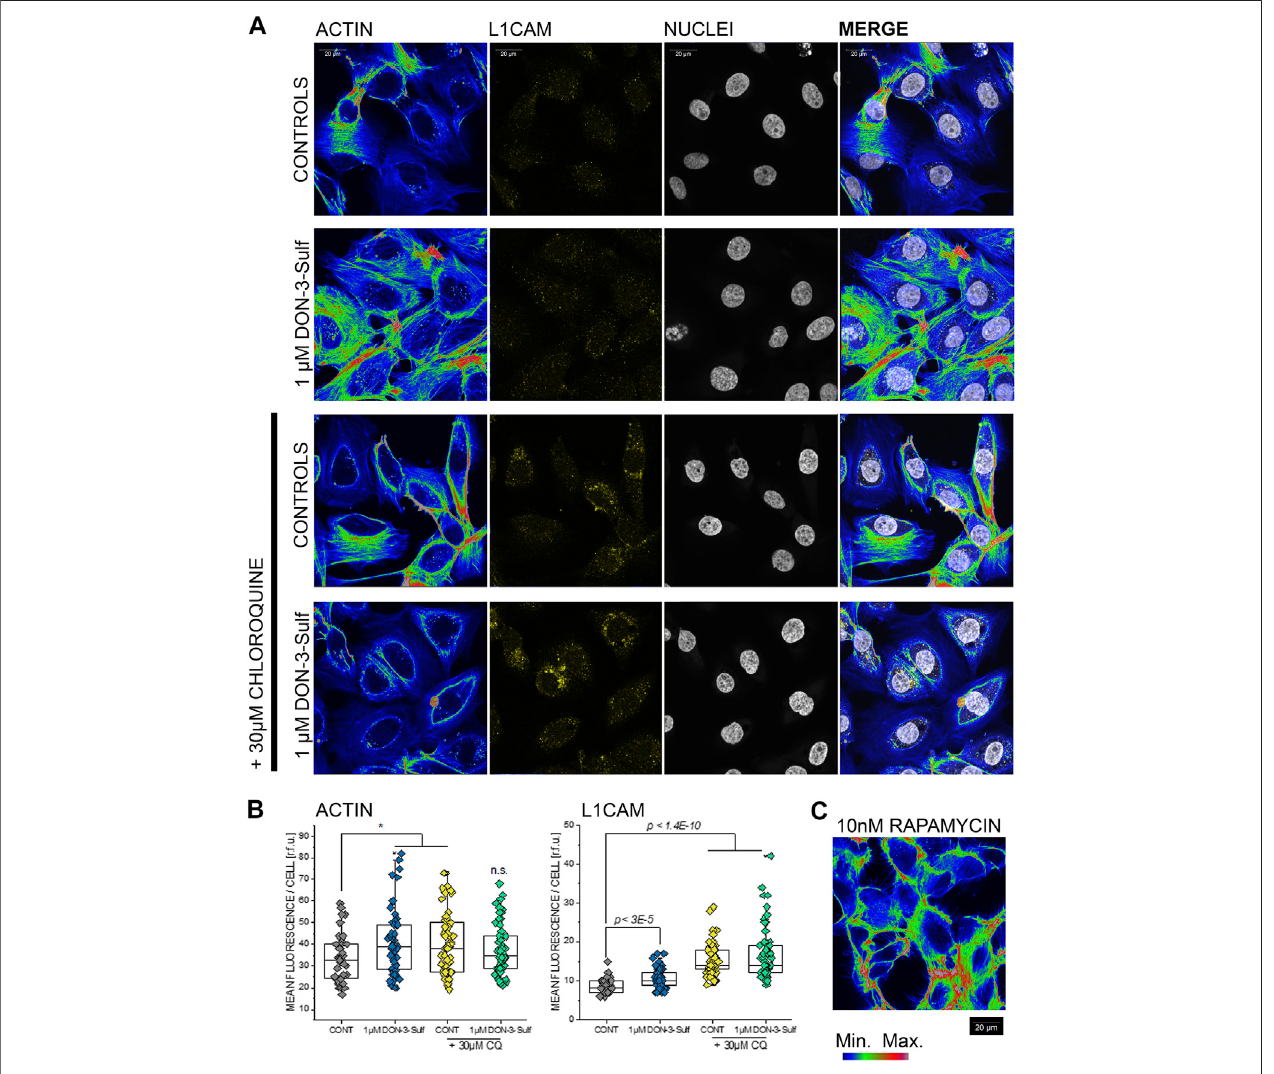
FIGURE 6 | Actin cytoskeleton and L1 cell adhesion molecule (L1CAM) in T24 cells. (A) Representative appearance of cells in control conditions and after 24 h incubation with 1 µM DON-3-Sulf and/or 30 µM chloroquine (CQ). (B) Mean fl uorescence signal intensity/cell expressed as relative fl uorescence units (r.f.u.). (C) Image representative of the appearance of actin cytoskeleton after incubation with rapamycin (10 nM, 24 h). Data result from the quanti fi cation of n > 40 cells p values refer to the comparison to controls at the Student ’ s t -test (*: p ≤ 0.05; scale bar: 20 µm).